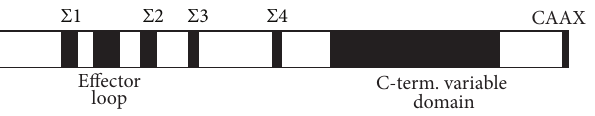
Figure 3: Schematic representation of the primary structure/motifs of Dexras1 contains all four components of the guanyl nucleotide binding and hydrolysis pocket ( Σ 1– Σ 4) arranged with an order and spacing similar to that of other G proteins. An effector loop region similar to that of Ras family members and a carboxyl terminus CAAX box site for prenylation are evident. The residues spanning from the Σ 4 domain to the CAAX box comprise an extended carboxyl terminus variable domain that accounts for the greater molecular mass of hormone-responsive, basic GTP-binding proteins as compared with other Ras family proteins. Reference: Graham et al.